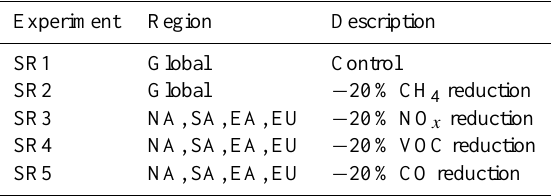
Table 2. Methane lifetime ( α ), feedback factor ( f ), and the methane lifetime change due to a 20% global reduction in methane, for each of the 11 CTMs, and the ensemble mean and standard deviation, as calculated in Fiore et al. (2009). Model abbreviations are explained in Fiore et al.